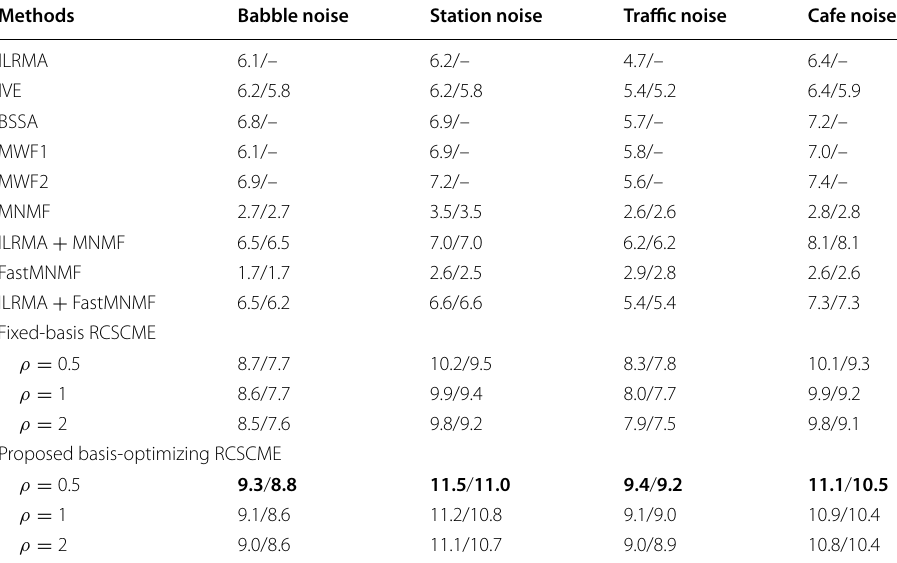
Each term represents “best‑iteration score [dB]/after‑200‑iteration (except for IVE; after‑4000‑iteration for IVE) score [dB].” Bold text indicates the maximum value